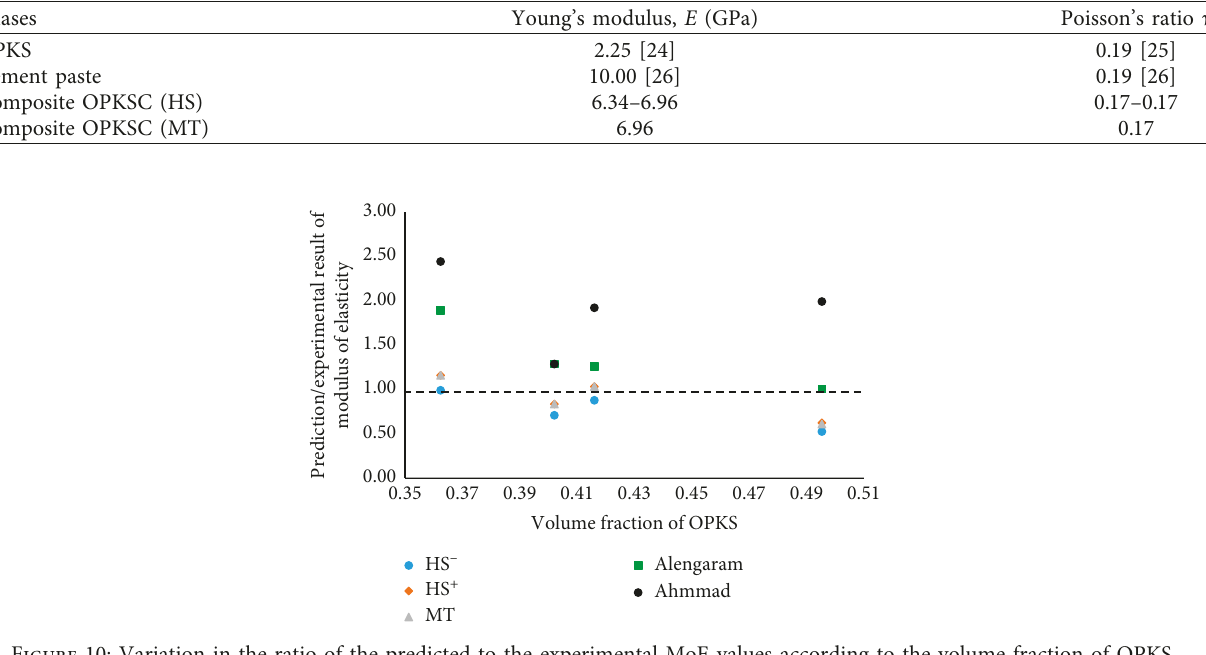
� 29.40% for the cubic c